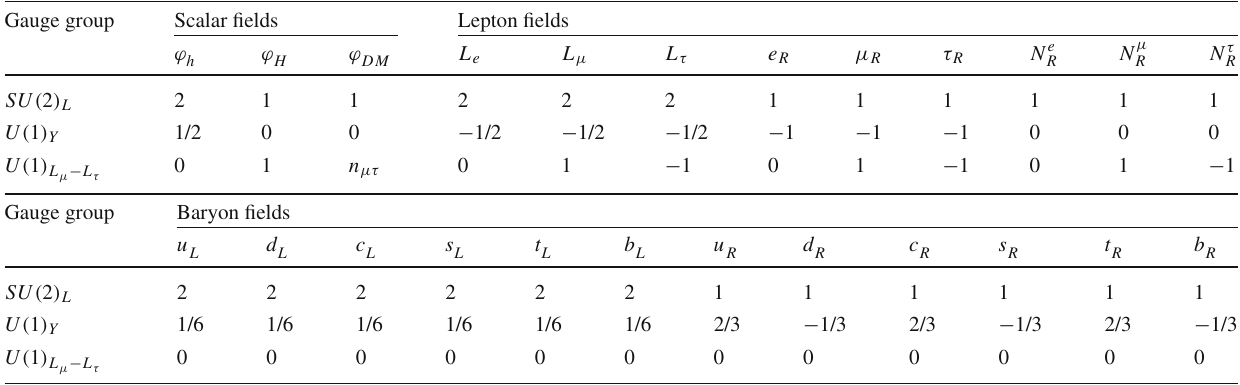
Table 1 Particle contents and corresponding charge assignments under various symmetry groups in the U ( 1 ) L Gauge group Scalar fields Lepton